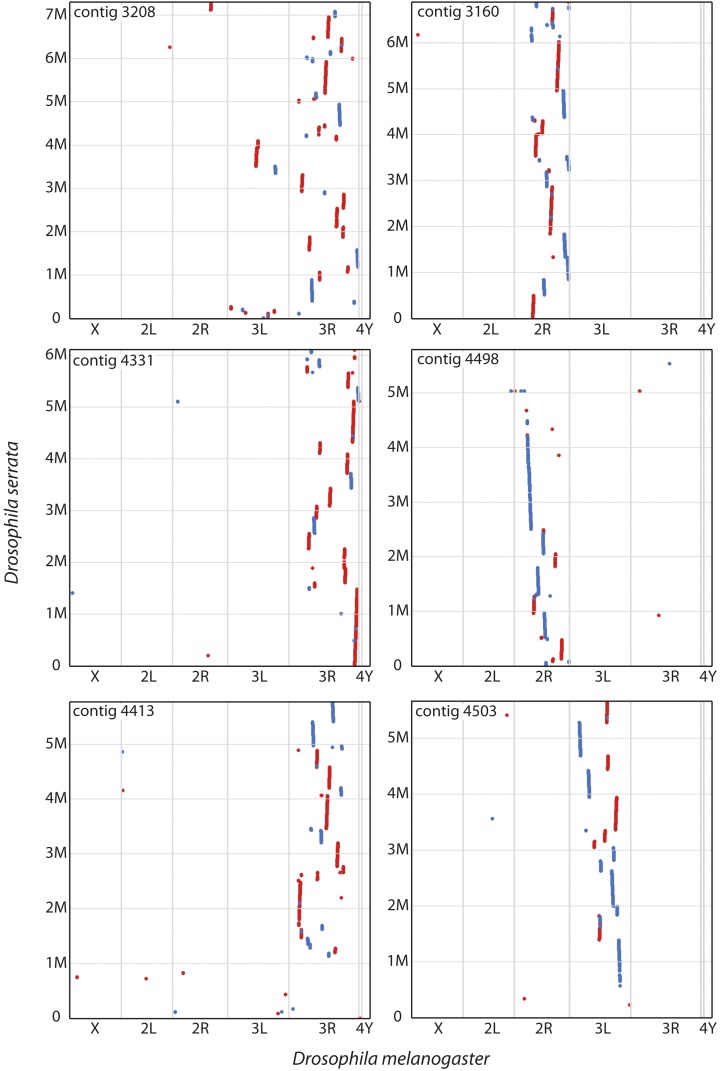
Alignment of the six longest contigs from the D. serrata assembly to D. melanogaster genome version 6.05. Red dots indicate a MUMmer alignment that matches to the D. melanogaster genome in the forward orientation; blue dots indicate a MUMmer alignment that matches to the D. melanogaster genome in the reverse orientation. M, million.